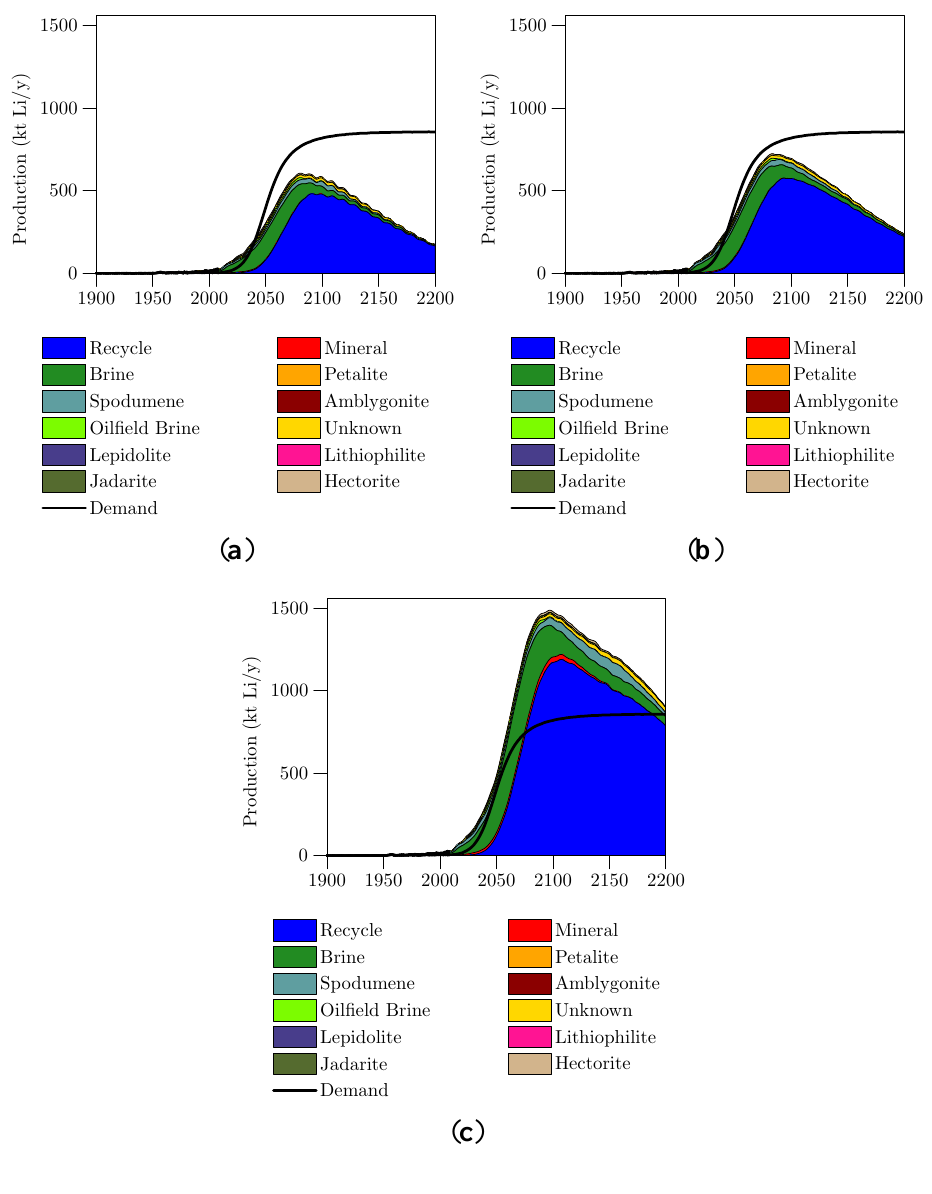
Figure 4. Projected lithium supply and demand by mineral type. ( a ) Case 1; ( b ) Case 2; ( c ) Case 3.